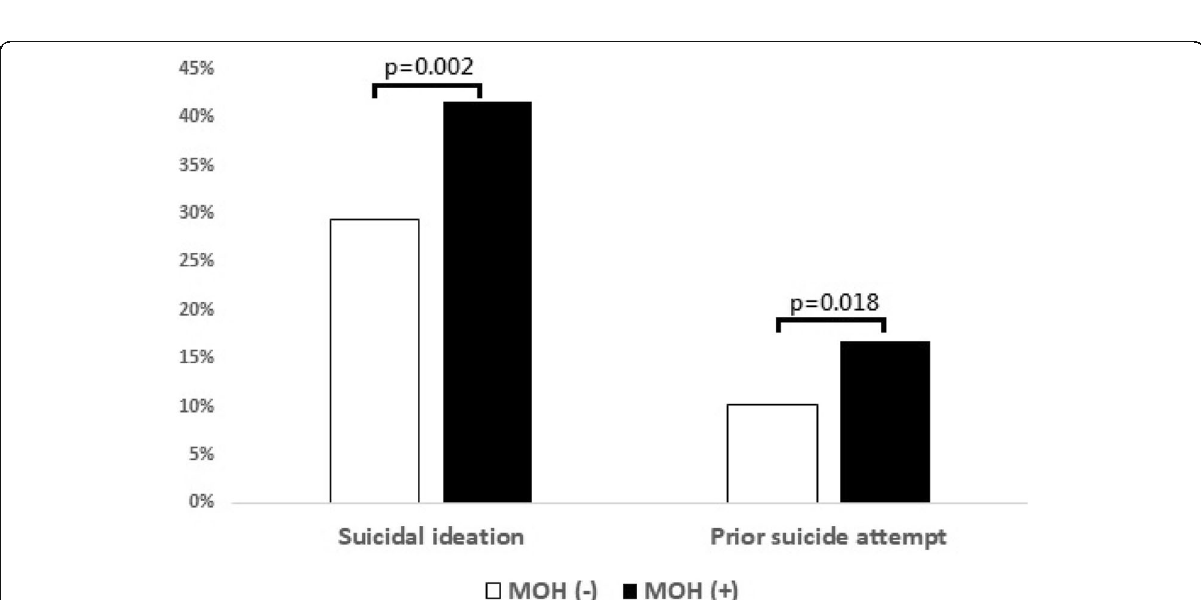
Fig. 2 Proportions of patients with suicidal ideation and prior suicide attempt in chronic migraine patients with and without medication-overuse